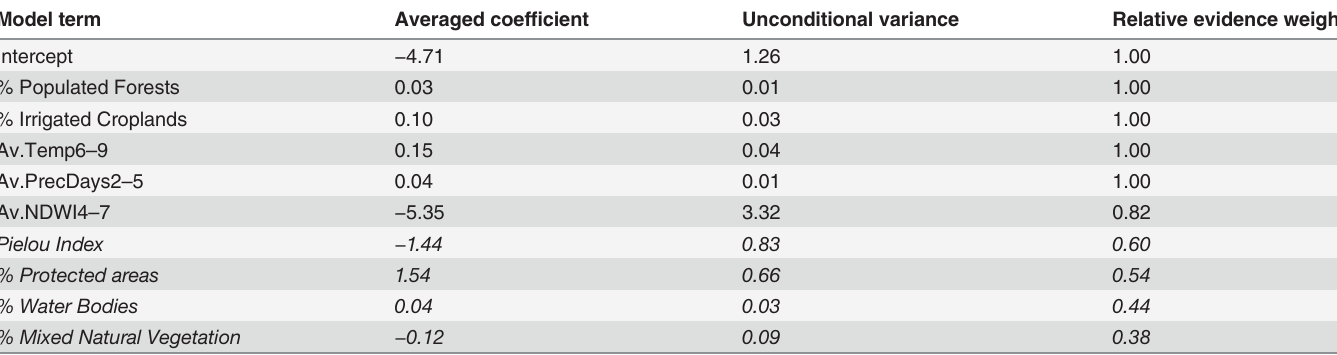
Table 3. Terms selected in the nine best